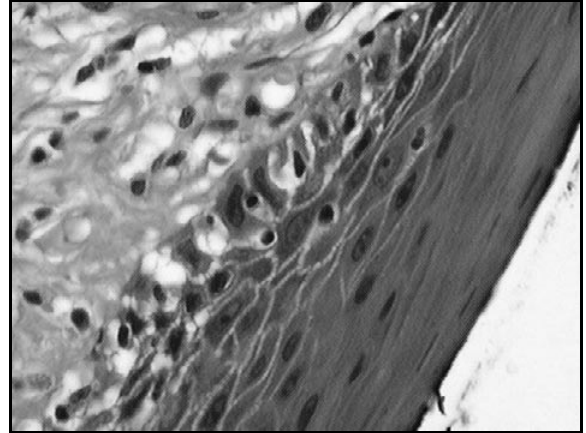
Figure 2 – Graft-versus-host disease in the tongue, displaying hyperkeratosis, hydropic degeneration and infiltration of lymphocytes in the basal layer (hematoxylin-eosin,